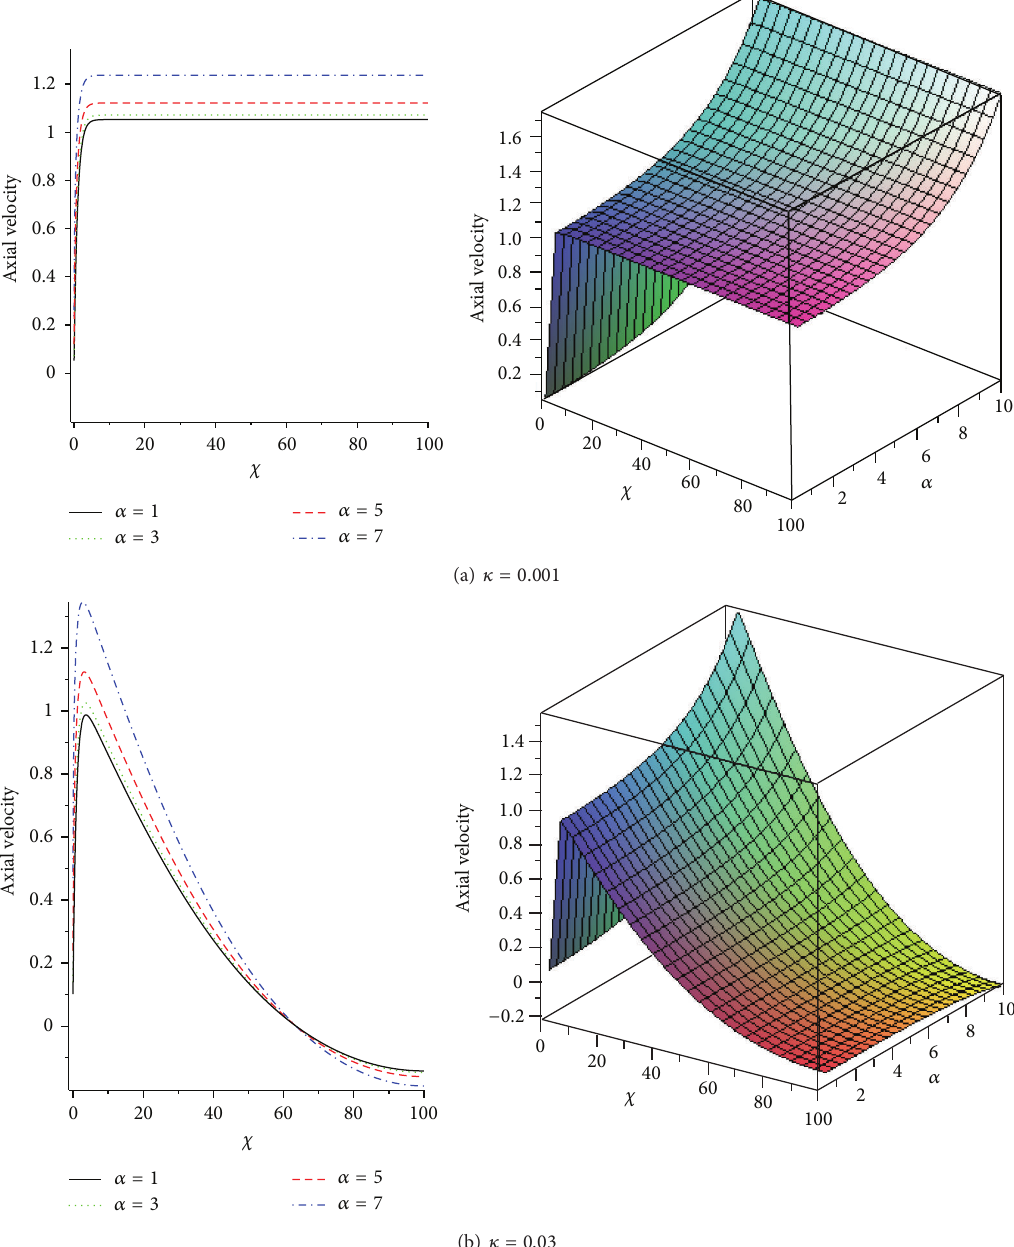
Figure 5: Effect of the energy parameter 𝛼 on the velocity profile obtained from the model with 𝜃 = 𝜋/2 , ℎ = 100 𝜆 , and 𝑙 = 0.05 for two different 𝜅 values: (a) 𝜅 = 0.001 and (b) 𝜅 = 0.03 .